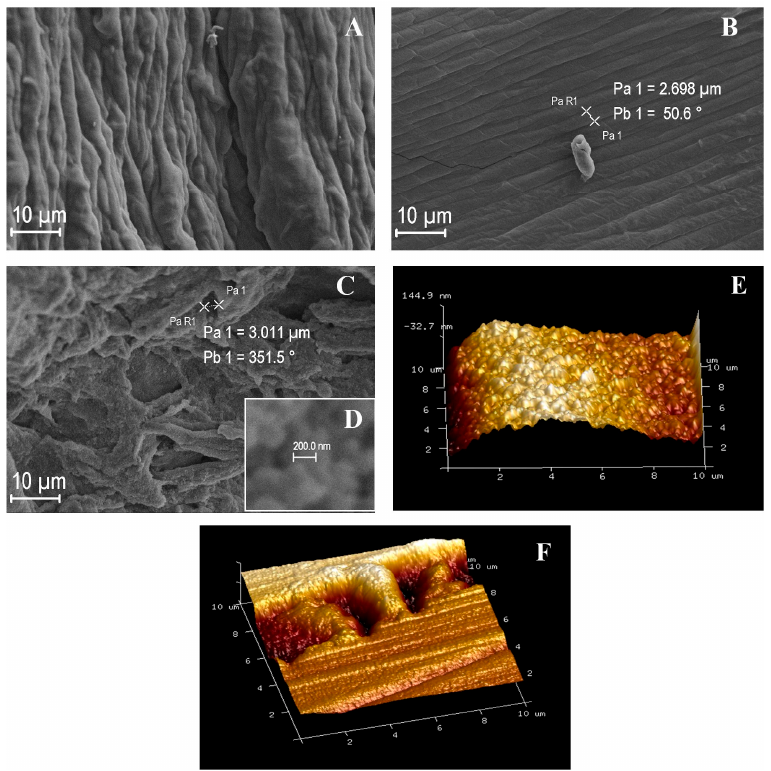
Figure 3. Scanning electron microscopy (SEM) images: ( A ) 17% lignin film; ( B ) 27.5% lignin film; ( C ) 38% lignin; ( D ) 38% lignin at 100,000×; ( E ) atomic force microscopy (AFM) image of 27.5% lignin film; and ( F ) AFM image of 38% lignin film.